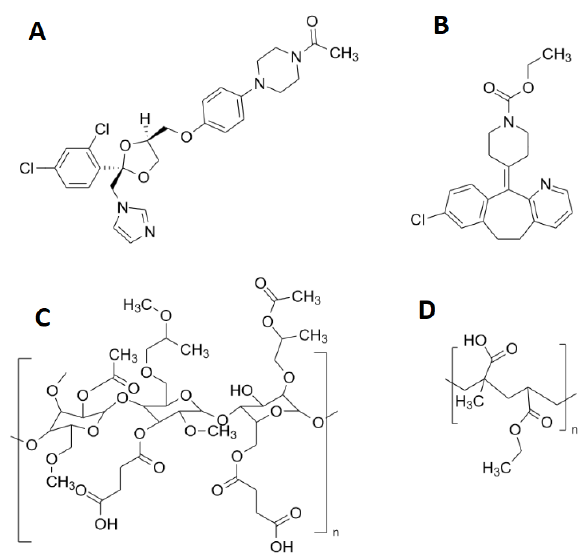
Figure 1. Chemical structures of the used materials: ( A ) ketoconazole; ( B ) loratadine; ( C ) Hydroxy- propyl methylcellulose acetate succinate; and ( D ) Eudragit L100-55.